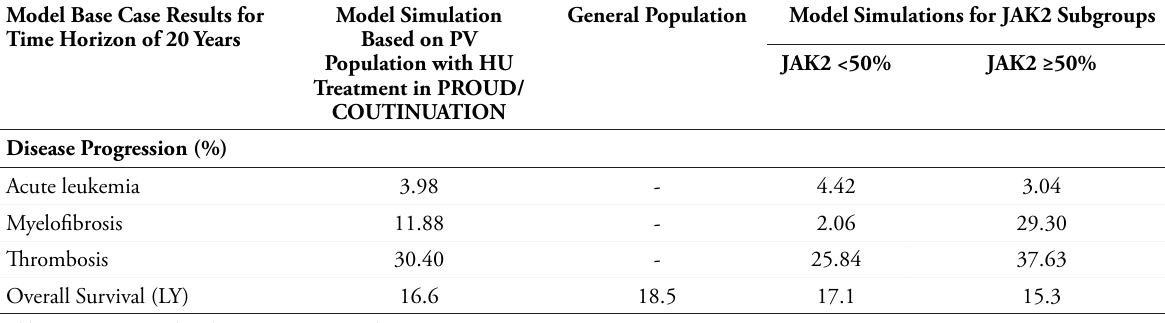
Table 3. Model Simulation Results Using Unadjusted Baseline Values for Age and JAK2 Model Base Case Results for Time Horizon of 20 Years